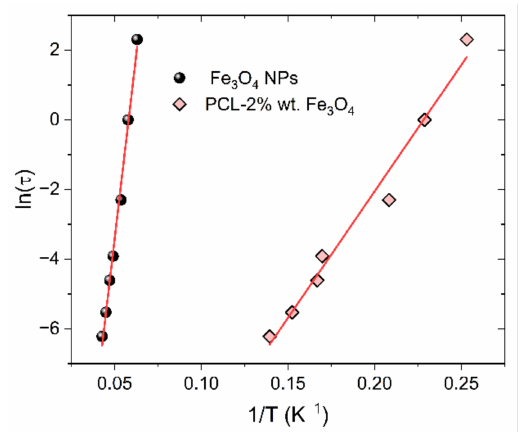
Figure 9. Arrhenius plots for Fe 3 O 4 nanoparticles and PCL fibres with Fe 3 O 4 contents of 2%.